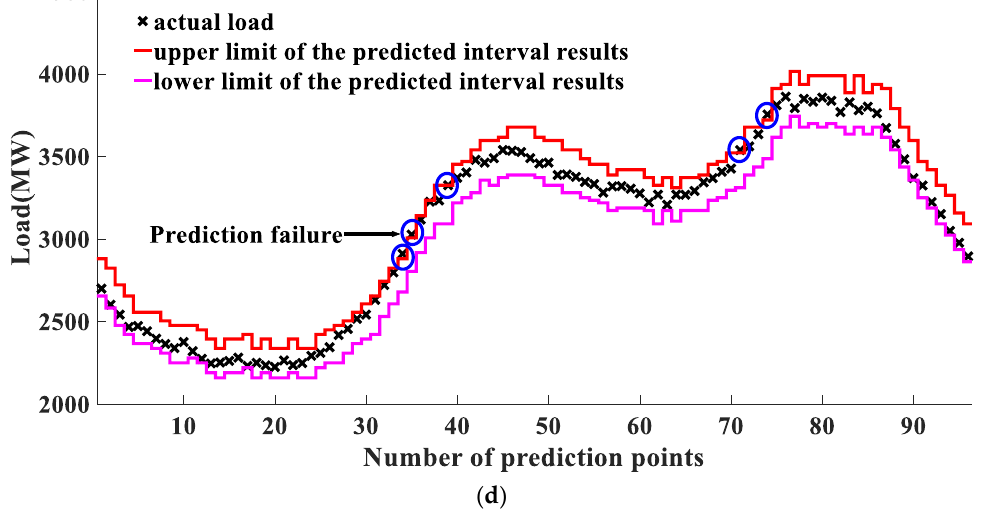
Figure 5. Prediction results of applying four methods in region 2: ( a ) Prediction results based on the optimal parameter K and t ; ( b ) prediction results of ANN; ( c ) prediction results based on ELM; ( d ) prediction results of GPR algorithm.